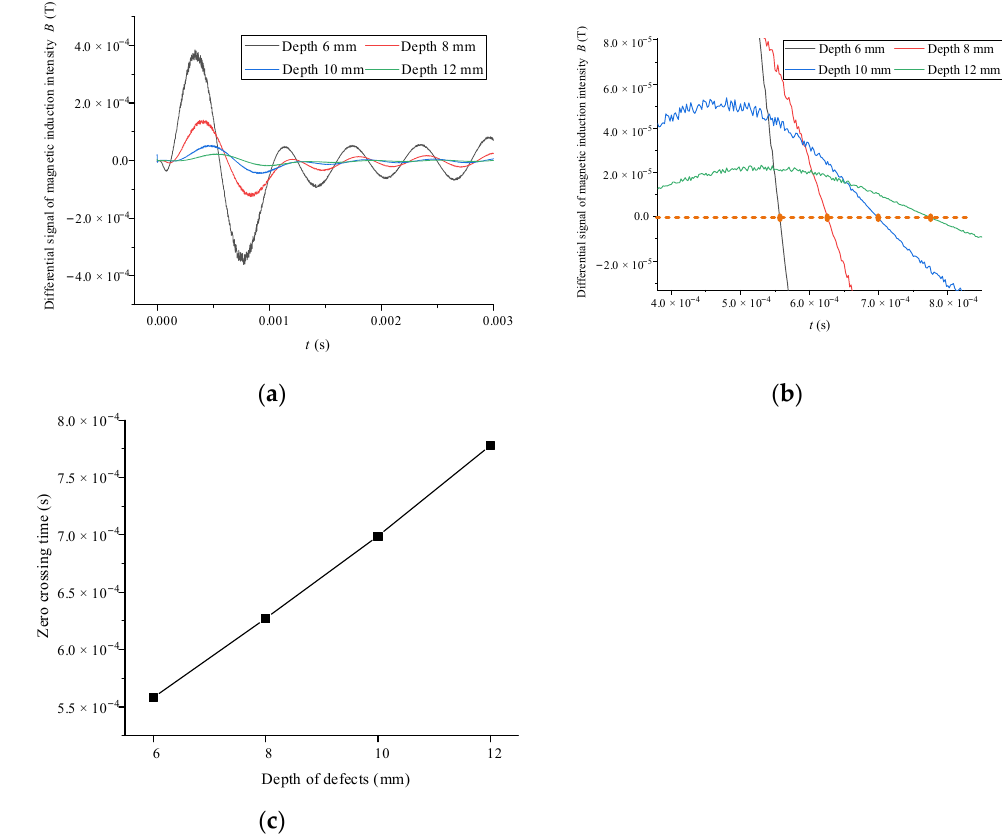
Figure 6. ( a ) Differential pickup signals of magnetic induction intensity under different defect depths; ( b ) ZCT of differential pickup signal under different defect depths; ( c ) effects of the defect depth on ZCT.